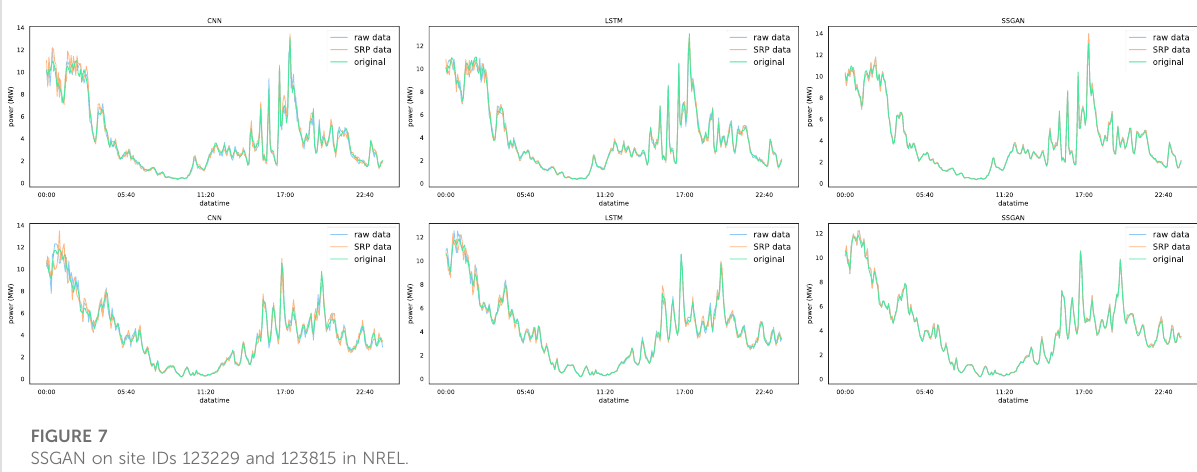
FIGURE 7 SSGAN on site IDs 123229 and 123815 in NREL.